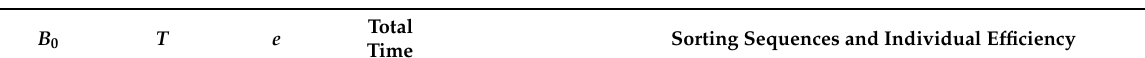
Table 4. Solutions of sorted negotiation model with constraints of both time and cost ( p = 0.95, q = 0.95 ) .